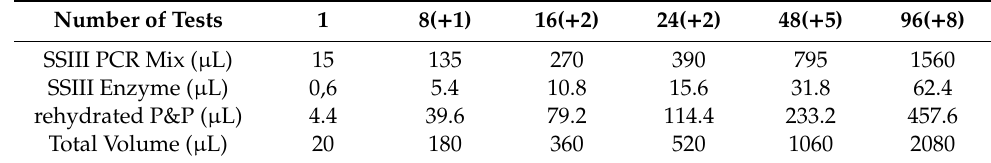
Table 4. PCR Mix preparation when using the Superscript ® III Platinium ®